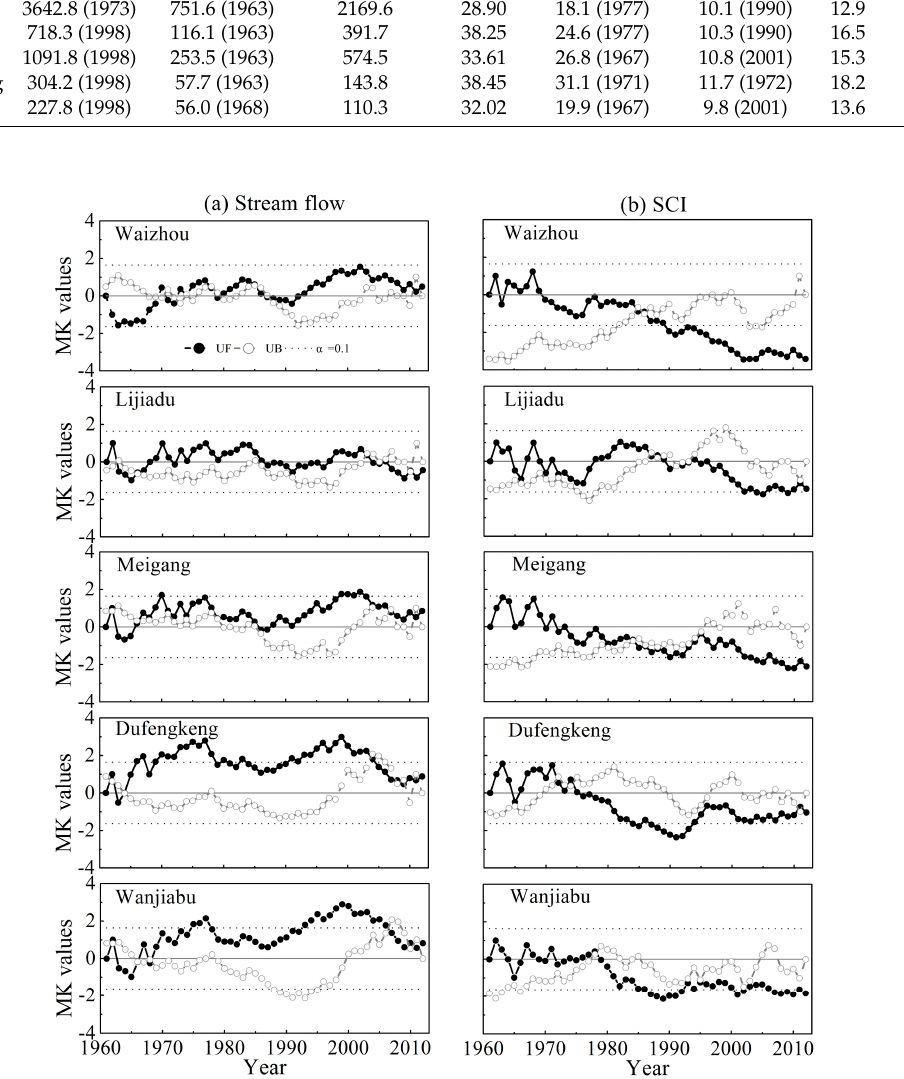
Figure 3. MK values of the: annual stream flow ( a ); and SCI ( b ) for the Poyang Lake Basin from 1961 to 2012.